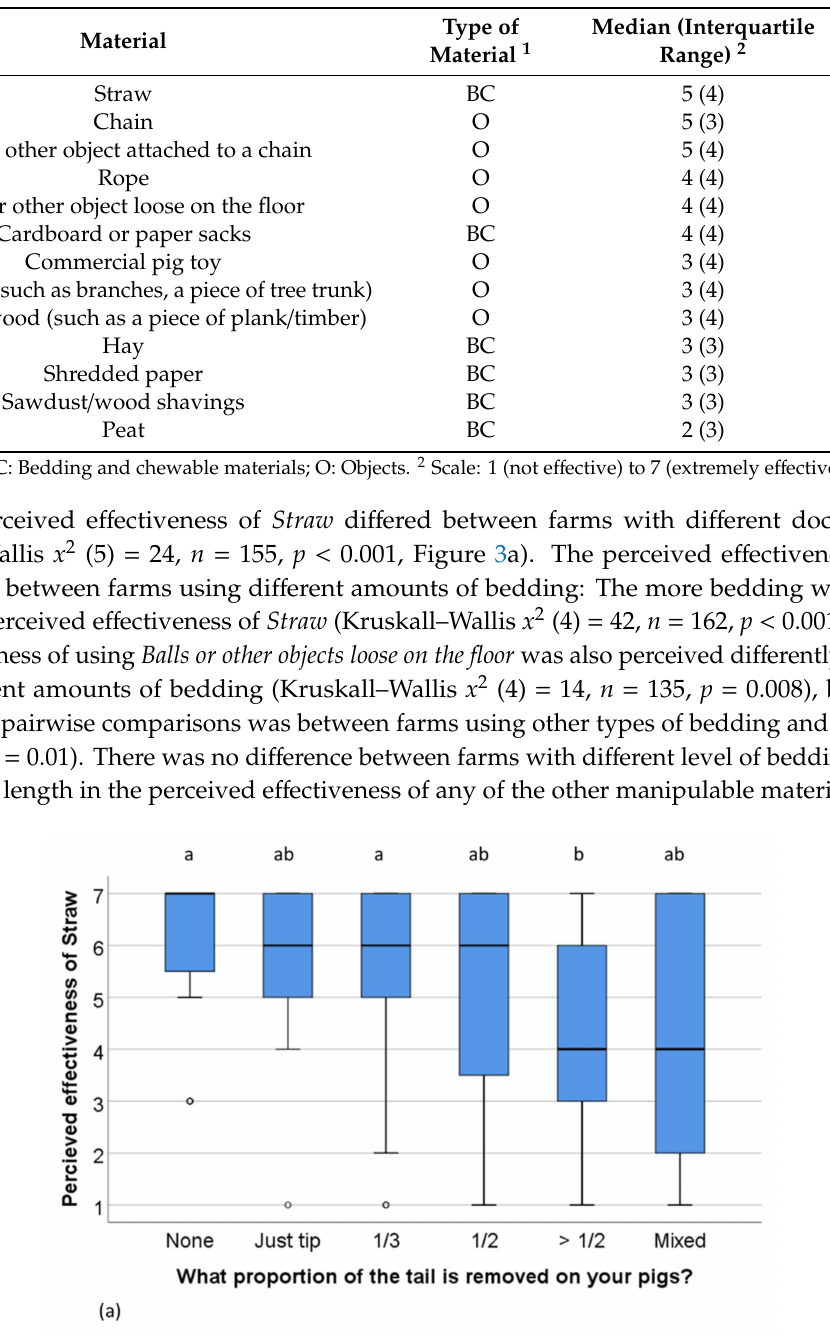
Table 6. Perceived e ff ectiveness in preventing tail biting of the di ff erent manipulable materials given in the questionnaires.